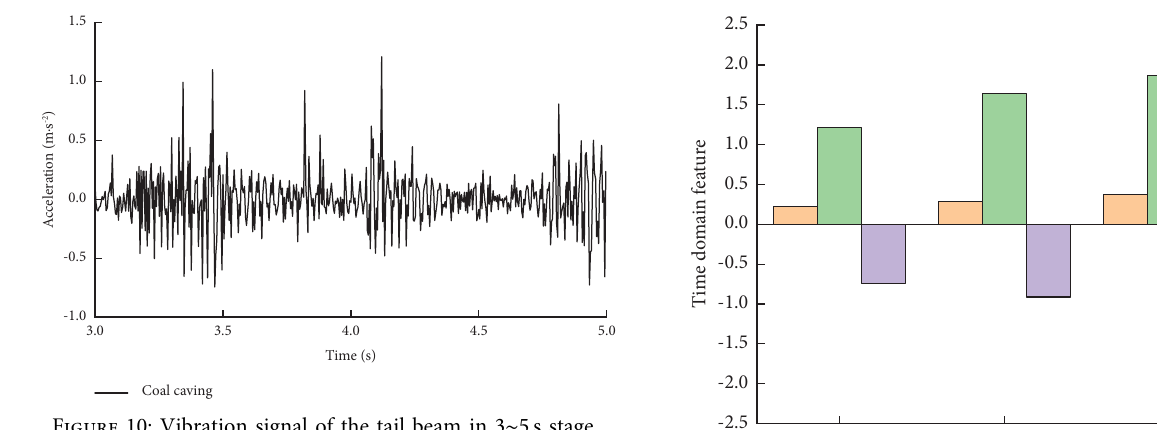
Figure 10: Vibration signal of the tail beam in 3 ∼ 5s stage.